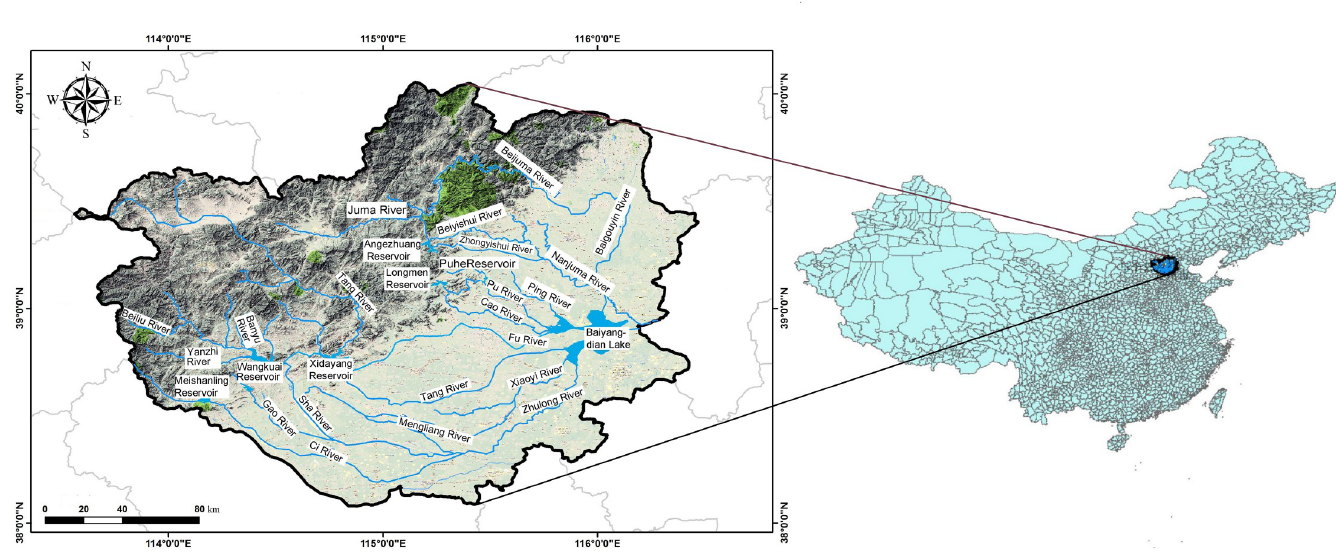
Fig 1. Map of the Baiyangdian Basin and its geographical location in